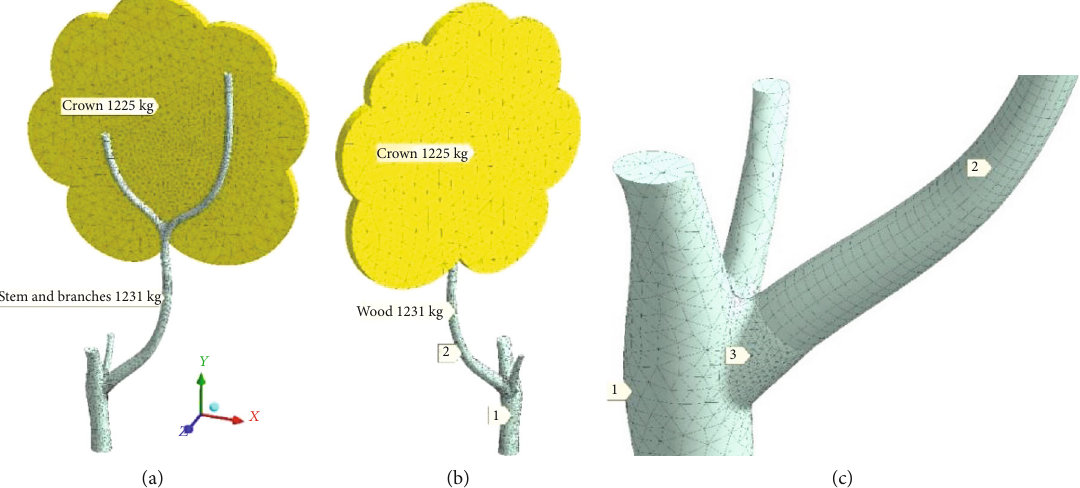
Figure 5: Meshes for: (a) leeward side of crown; (b) windward side of crown; (c) trunk 1 with junction 3 to branch 2.